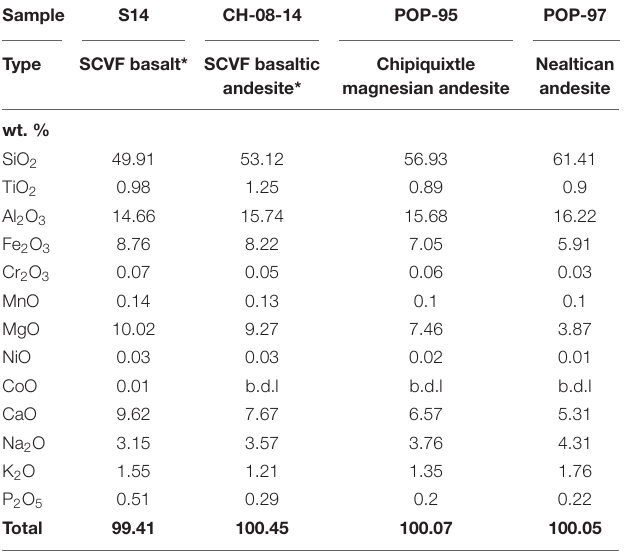
FIGURE 9 | Mg# and Anorthite vs. temperature diagram showing results of MELTS models (Gualda et al., 2012; Ghiorso and Gualda, 2015) for mid- to upper crustal evolved and mafic magma endmembers at the PVC. Whole-rock compositions used as starting compositions are given in Table 2 . Results from 2-pyroxene-thermometry ( Figure 7 ) for evolved (yellow field) and mafic (blue) magmatic environment as well as hybrid domain (green) are given for reference. Observed compositional ranges for T1a, T1b and T2 orthopyroxene (opx) and clinopyroxene (cpx) philocrysts are given on the right-hand y -axis, and for plagioclase philocrysts on the left-hand y axis.